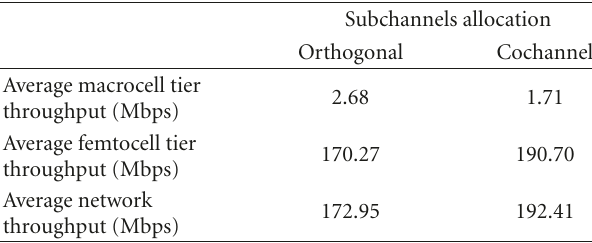
Table 1: Performance